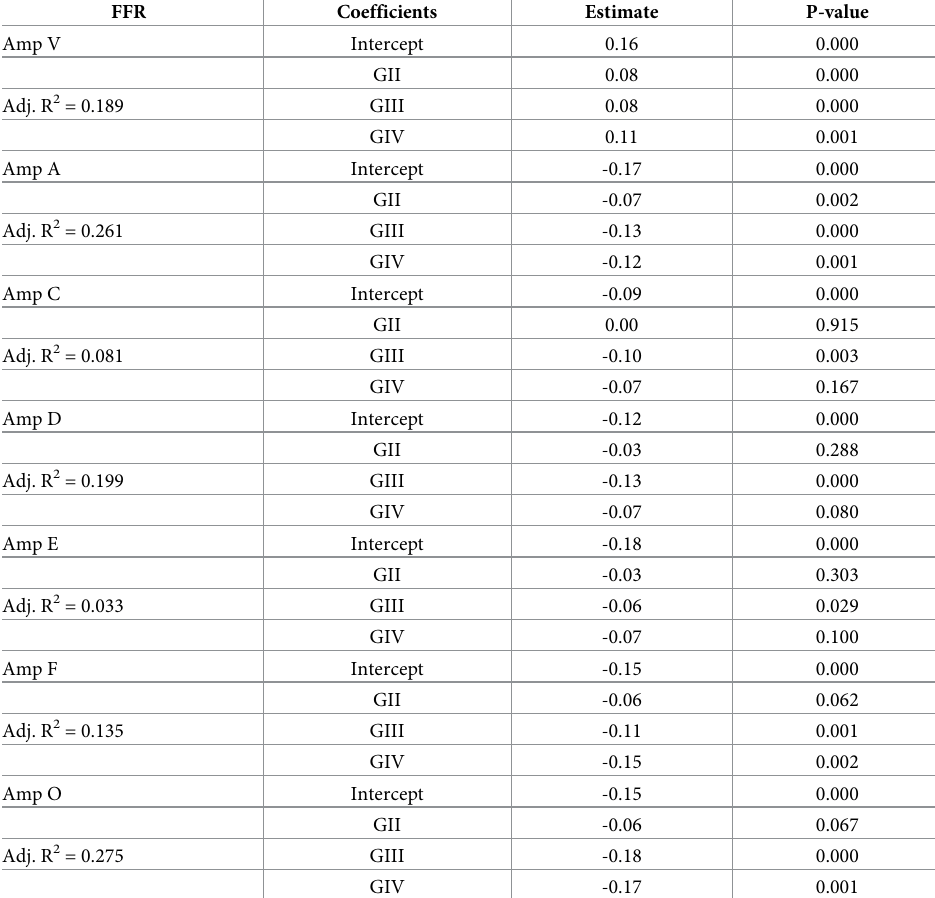
Table 4. Regression analysis of the Frequency-Following Response amplitude components in relation to age